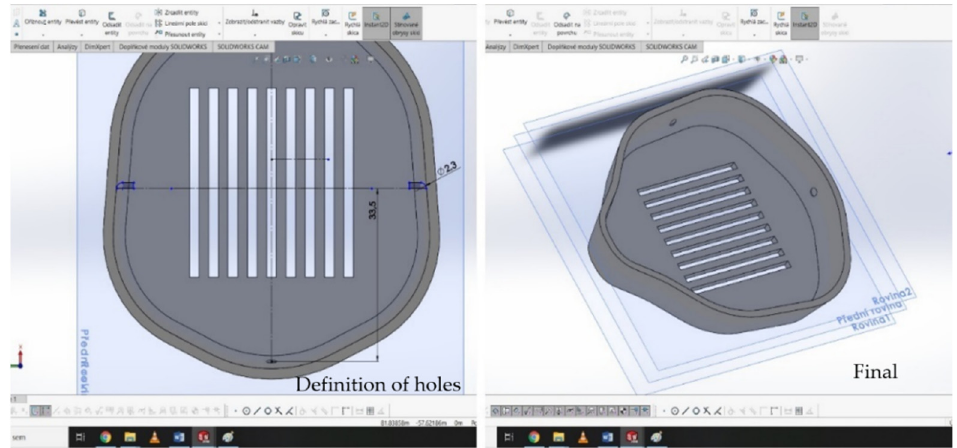
Figure 5. Mirroring holes and looking in planes (individual steps).